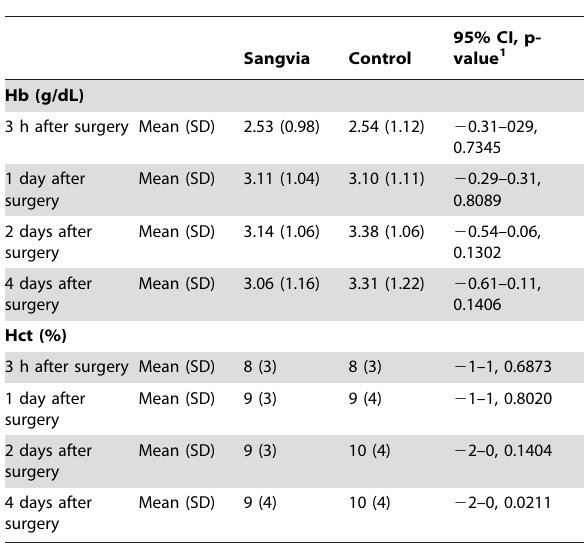
Table 3. Hb and Hct change from screening per treatment group (PP analysis